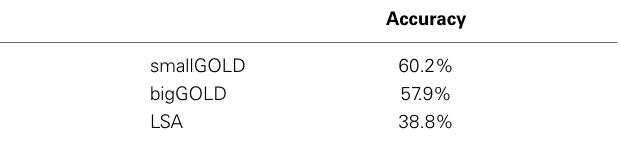
Table 4 | Classifier accuracy on the Chiarello et al. (1990) associated-only, both associated and similar, and similar-only word pairs.